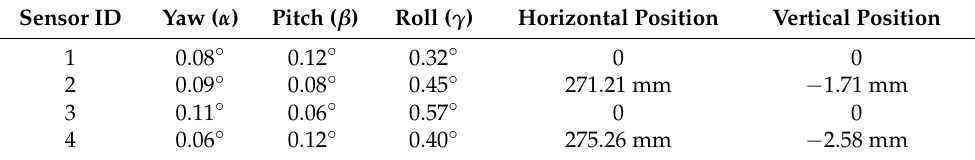
Table 1. Calibration result of the four structured light